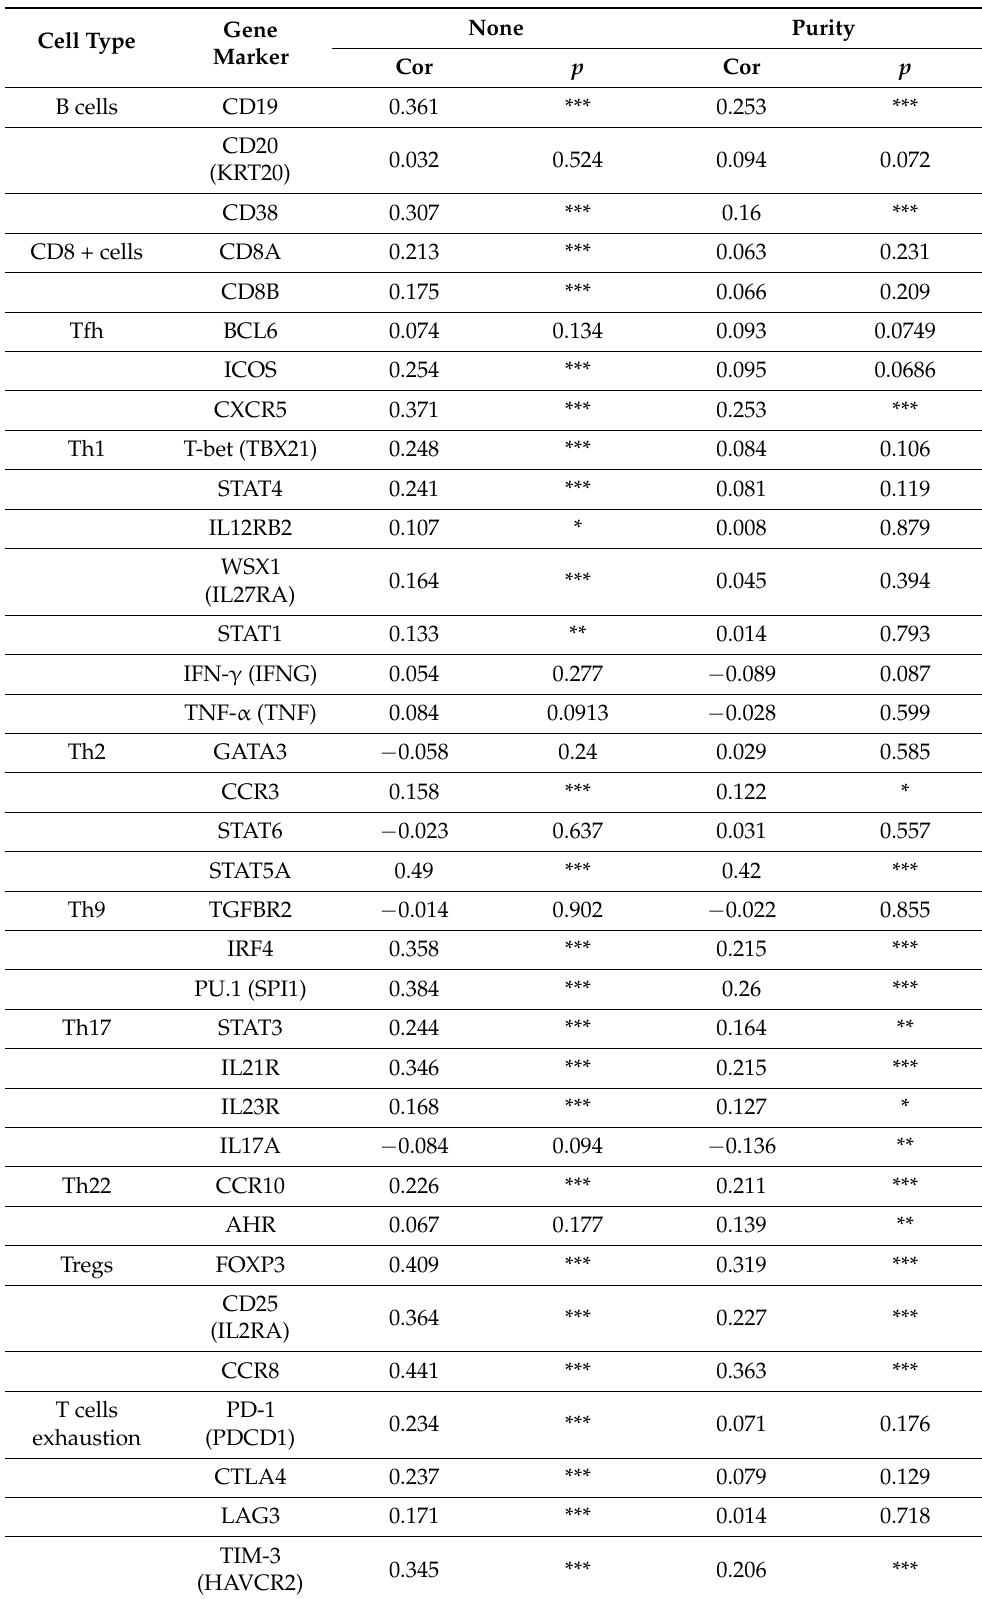
Table 4. The connection between EPHA3 level with immune cell genes markers based on